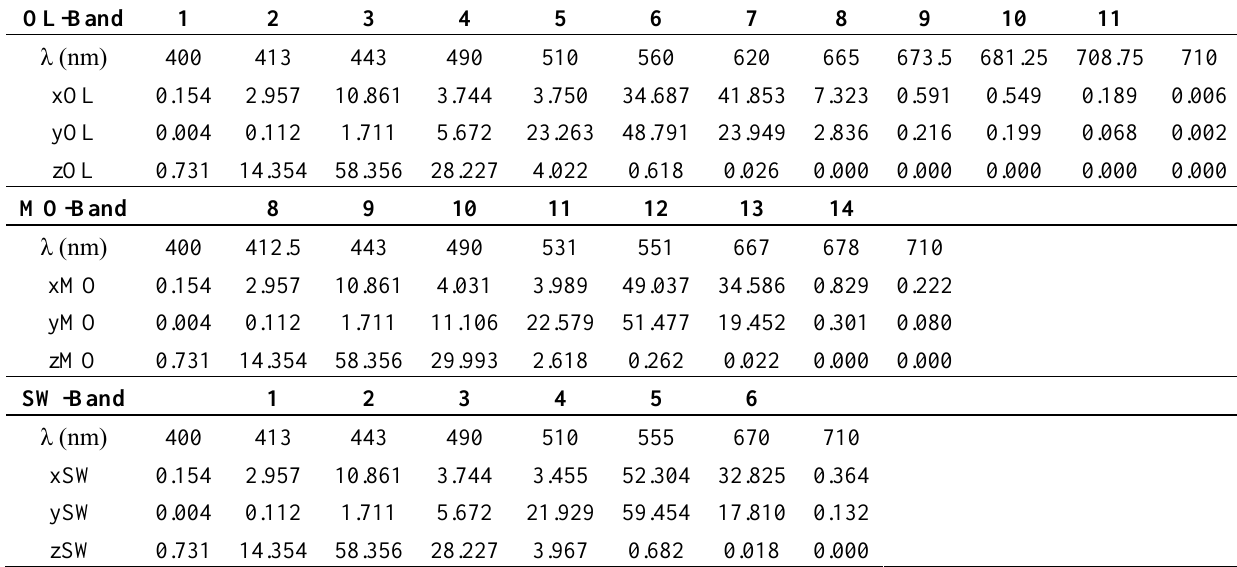
Table 3. Linear coefficients to calculate the chromaticity values based on OLCI (OL), MODIS (MO) and SeaWiFS (SW) bands.